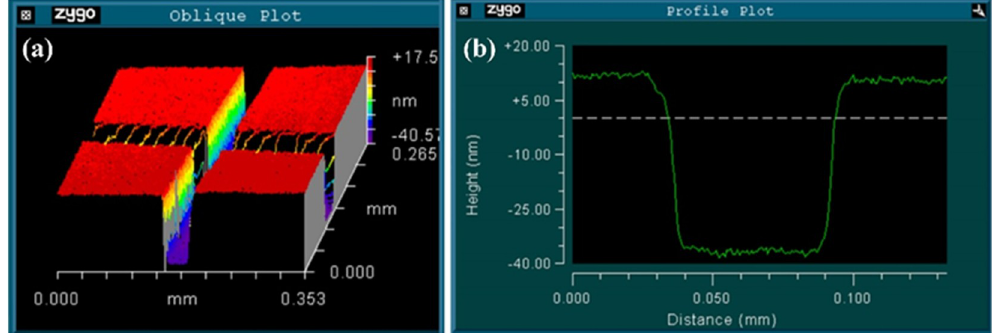
Figure 5. Photos during the fiber splicing process. ( a ) the GI-MMF tip ( left ) and the step-index multimode fiber (SI-MMF) tip ( right ) before splicing; ( b ) the GI-MMF tip ( left ) and the SI-MMF tip ( right ) after splicing, which had almost no deformation; ( c ) image of the fiber probe before film coating.